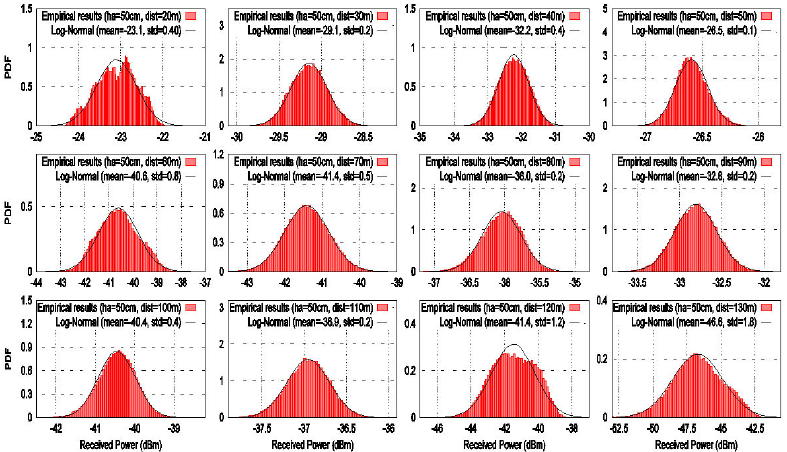
Figure 11. Histograms at each distance from 20 m to 130 m for a height of 50 cm over the river within